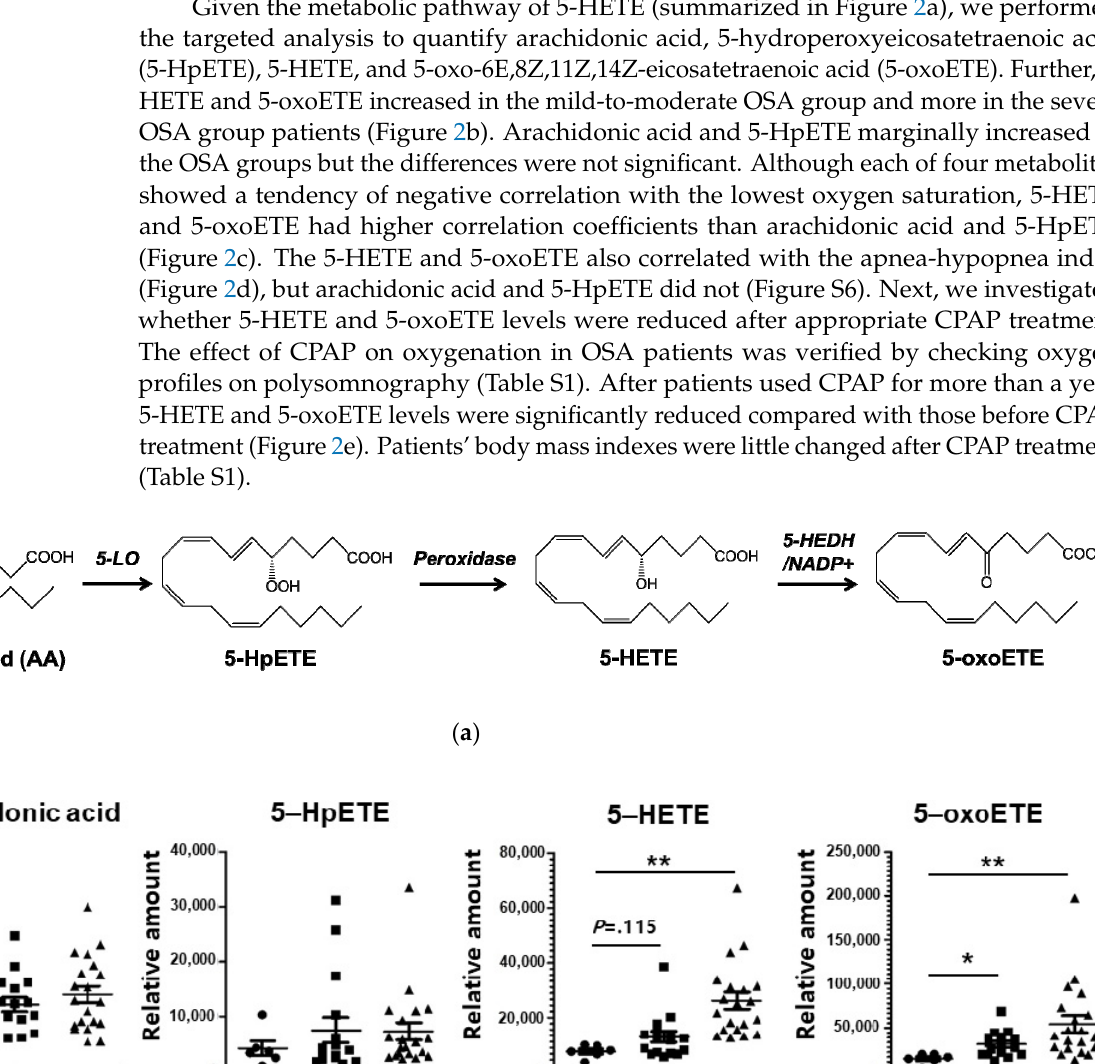
Figure 1. Identification of 5 ‐ HETE as a hypoxic biomarker in the obstructive sleep apnea syndrome. ( a ) Results of the partial least squares discriminant analysis of urine specimens from patients with the obstructive sleep apnea syndrome and controls. In a pilot cohort, moderate to severe OSA patients ( n = 20) with AHI > 10 were compared to the simple snorers or healthy subjects as controls ( n = 38) with AHI < 5. The peaks of 5 ‐ HETE, which was one of the crucial urine metabolites distinguishing two groups, were visualized in comparison with the standard material of it. ( b ) List of three major metabolite biomarkers for the obstructive sleep apnea, which were identified and significantly higher in urine specimens from OSA patients than in those from controls. ( c ) Levels of three identified metabolites in a different group as a verification cohort—25 healthy controls, 60 OSA patients. The horizontal lines indicate means, and I bars are standard deviations. ( d ) Correlation between the levels of candidate metabolite markers and the lowest oxygen saturation or apnea-hypopnea index (AHI) from polysomnographic studies in the verification cohort.